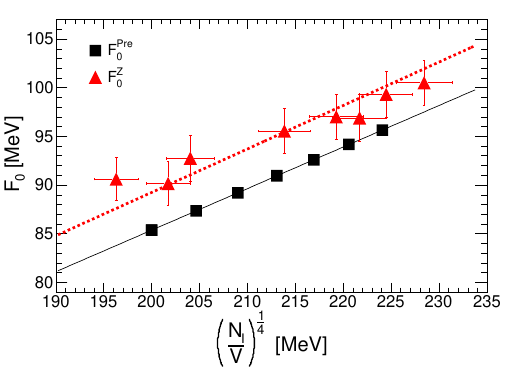
Figure 18 . Comparisons of the decay constant Figure 19 . Comparisons of the chiral conden- F Z with the prediction F Pre . The solid black sate h (cid:22) i Z with the prediction h (cid:22) i Pre . The 0 0 MS line and dashed red line represent the (cid:12)tting solid black line and dashed blue line represent results. the (cid:12)tting